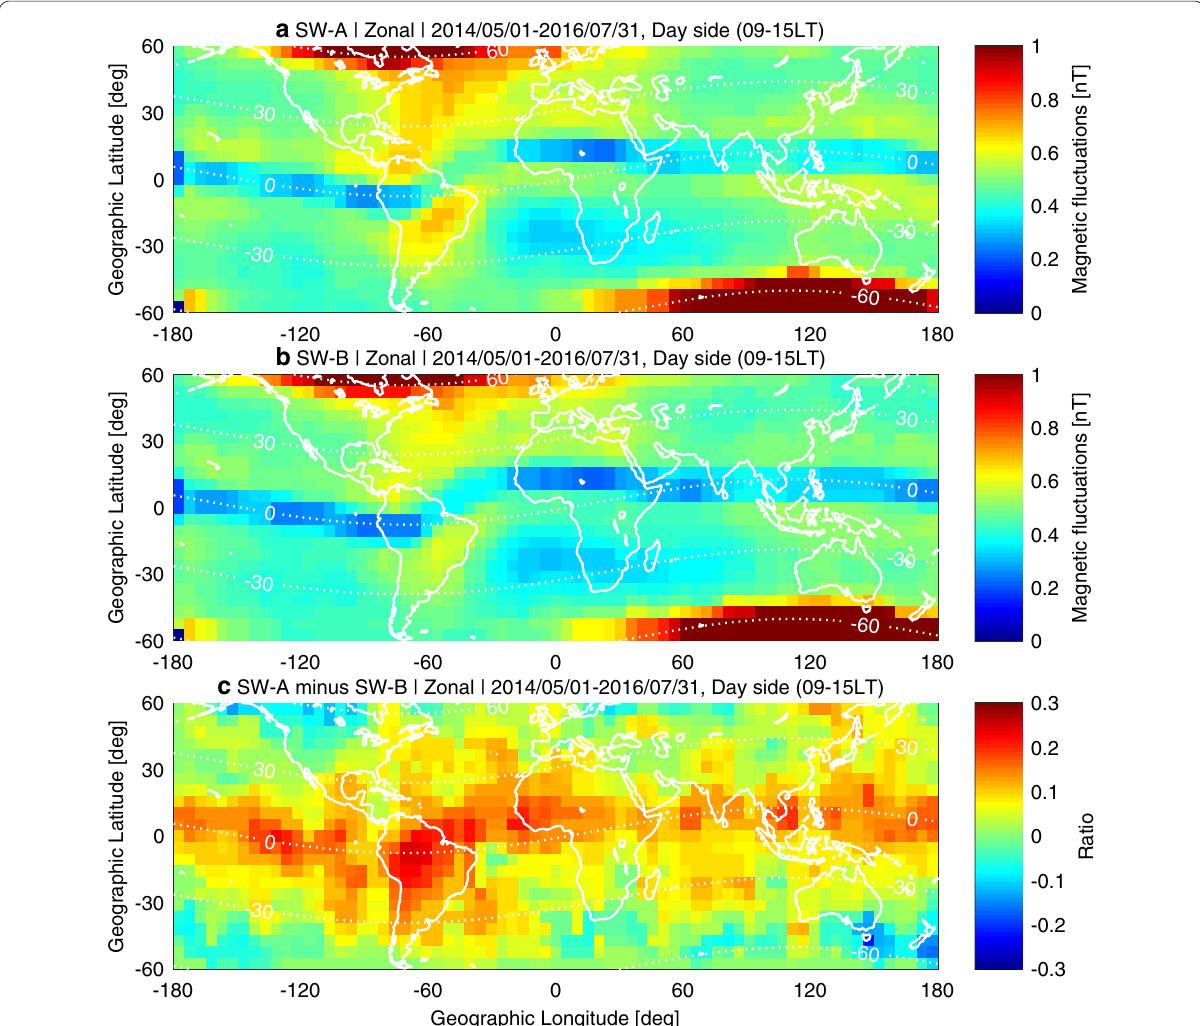
Fig. 6 Difference in global distribution of the MRs between SW-A and SW-B. Global distribution of the MR amplitudes of the zonal component on the dayside (9–15 LT) as observed by a SW-A and b SW-B within the time period May 1, 2014–July 31, 2016. The bottom panel c shows the difference in amplitudes (SW-A minus SW-B) normalized with the amplitudes of SW-A in each